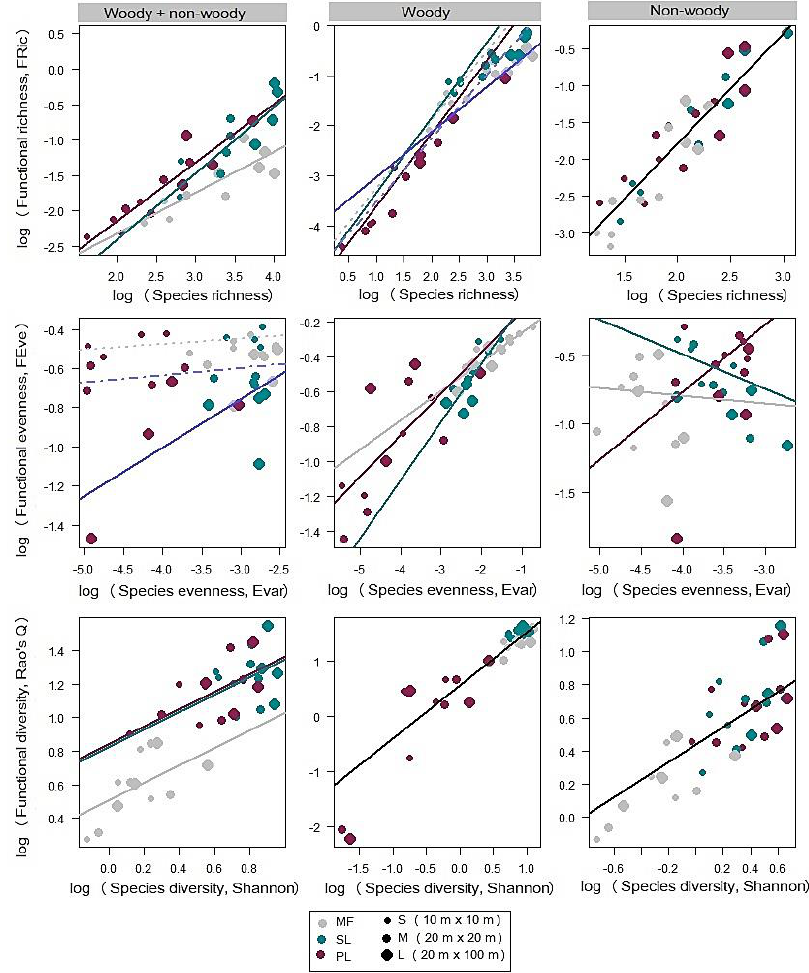
Figure 5. Variations in the species versus functional diversity relationships concerning habitat disturbance (MF = mature forests, SL = shrublands and PL = plantations), spatial scale (L = large scale, M = medium scale and S = small scale), and vegetation layers. When a mixed-effect model (Equation (5)) shows a significant interaction effect concerning disturbance (X × disturbance) or spatial scale (X × spatial scale), we fitted separate lines (i.e., separate slopes and intercepts) for disturbance or spatial scale; when both disturbance and spatial scale show a significant effect, we fitted six lines (three for disturbance and three for spatial scale); when the interaction effect was non-significant, but disturbance or spatial scale effect was significant, we fitted different lines with a different intercept but a common slope; when the model shows only a significant effect concerning species diversity, we fitted a single line. Concerning disturbance effects, a grey line represents mature forests, blue represents shrublands and red represents plantations; concerning the spatial scale effects, a fainted line represents small scale, intermittently dotted lines represent medium scale, and solid lines represent large scale. See Table S2 for detailed statistical